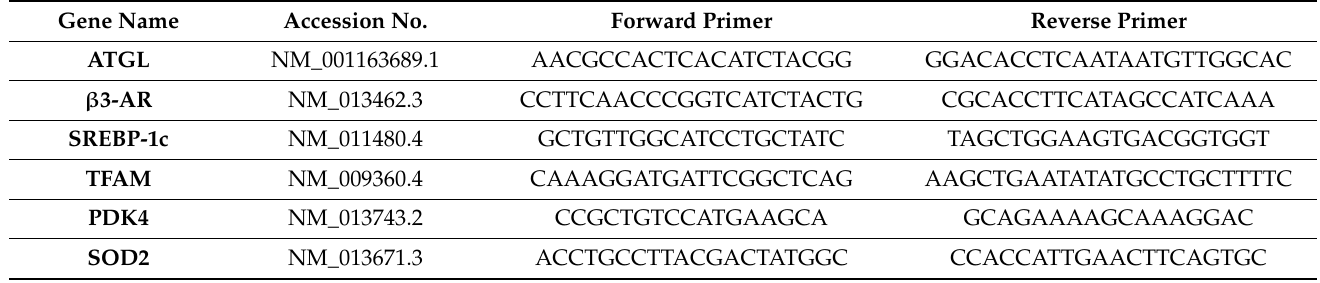
Table 1. Primer sequences for